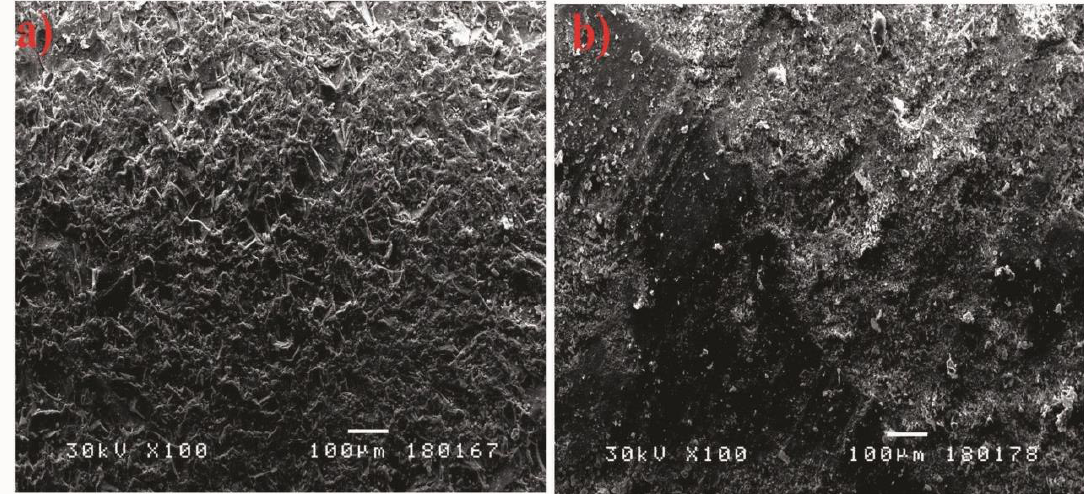
Figure 10. Reference concrete sample ( a ) and WG concrete sample ( b ) at 100× magnification.